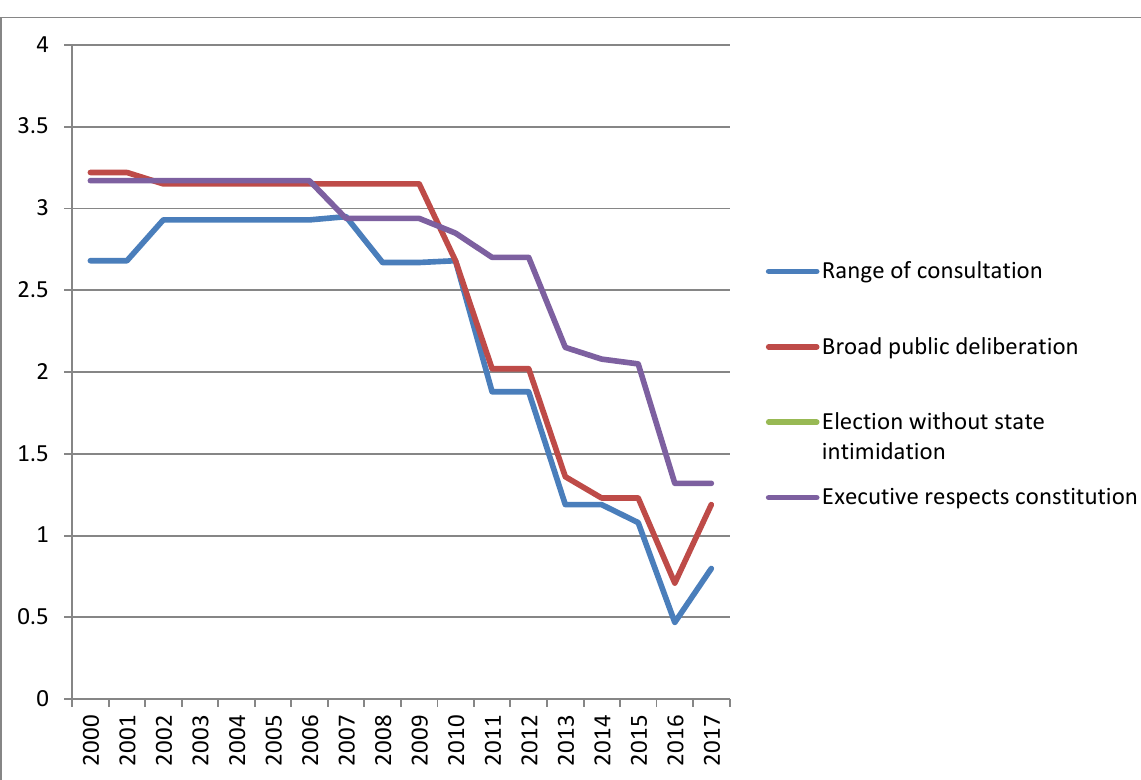
Fig. 1: Growing Authoritarianism in